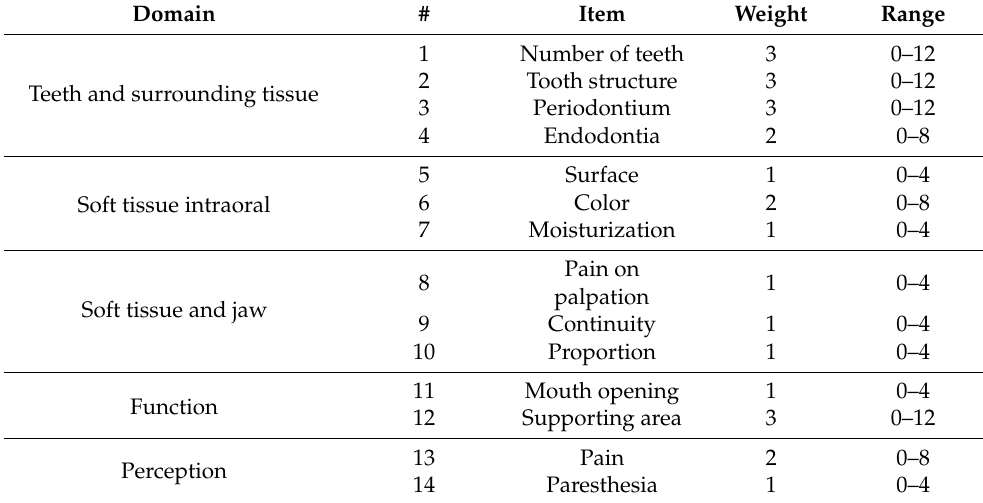
Table 2. Physical Oral Health Index (PhOX) domains and weights with the range for the values of each item. Translated domains and items from the Physical Oral Health